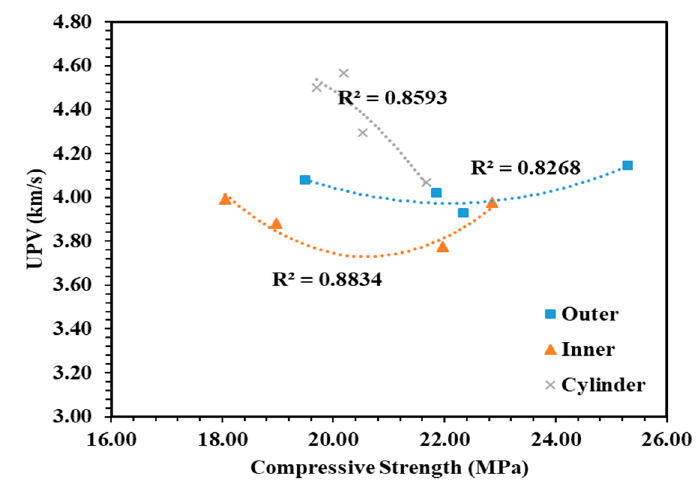
Figure 7. Relationship between compressive strength and UPV values of inner cores, outer cores, and cylinder specimens of all four groups at 91 days.